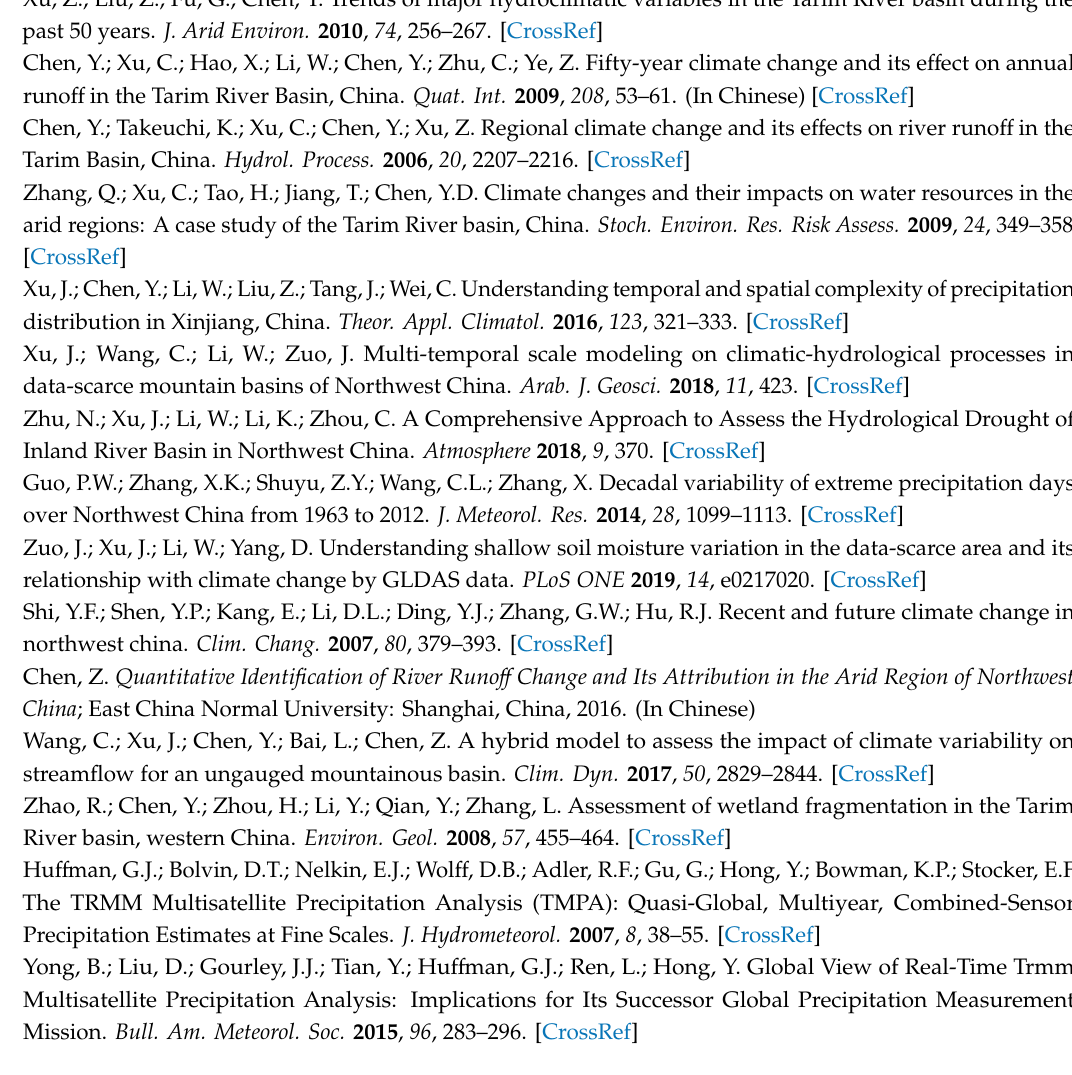
Table S1: parameters of BGD-based polynomial